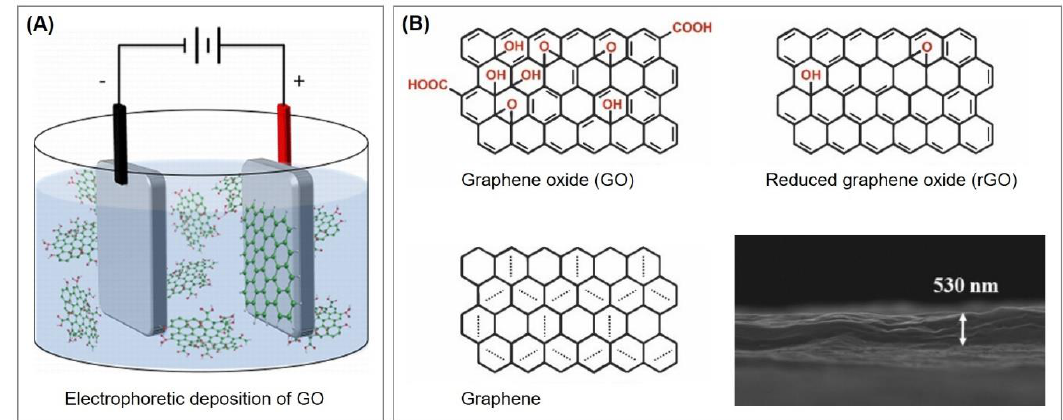
Figure 22. ( A ) Schematic representation of electrophoretic deposition, reproduced with permission from the authors of [159], copyright 2013, American Chemical Society. ( B ) Structures of graphene oxide (GO), reduced graphene oxide (rGO), and graphene, reproduced from the paper [143]. Cross-sectional FE-SEM image of deposited rGO membrane in layer-by-layer morphology. Here, EPD was performed at RT and the resulting membrane was detached from the substrate by electrochemical etching. Reproduced with permission from the authors of [160], copyright 2014, American Chemical Society.